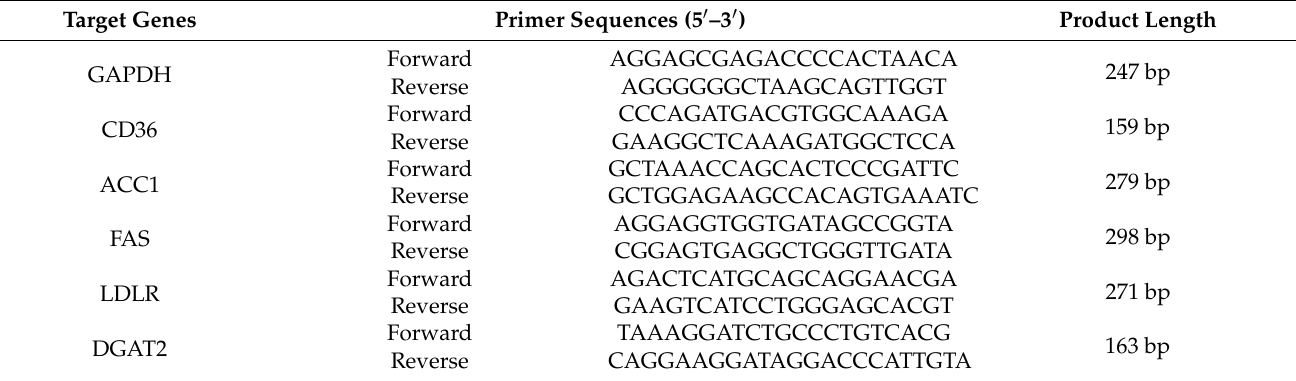
Table 1. Primer sequences and the length of the target